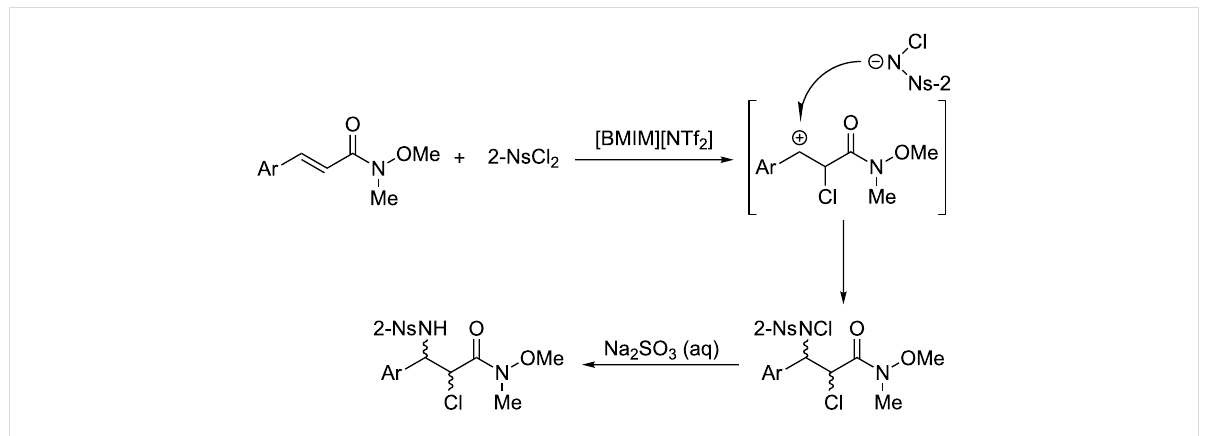
Scheme 6: Proposed mechanism of aminochlorination of α , β -unsaturated Weinreb amides.